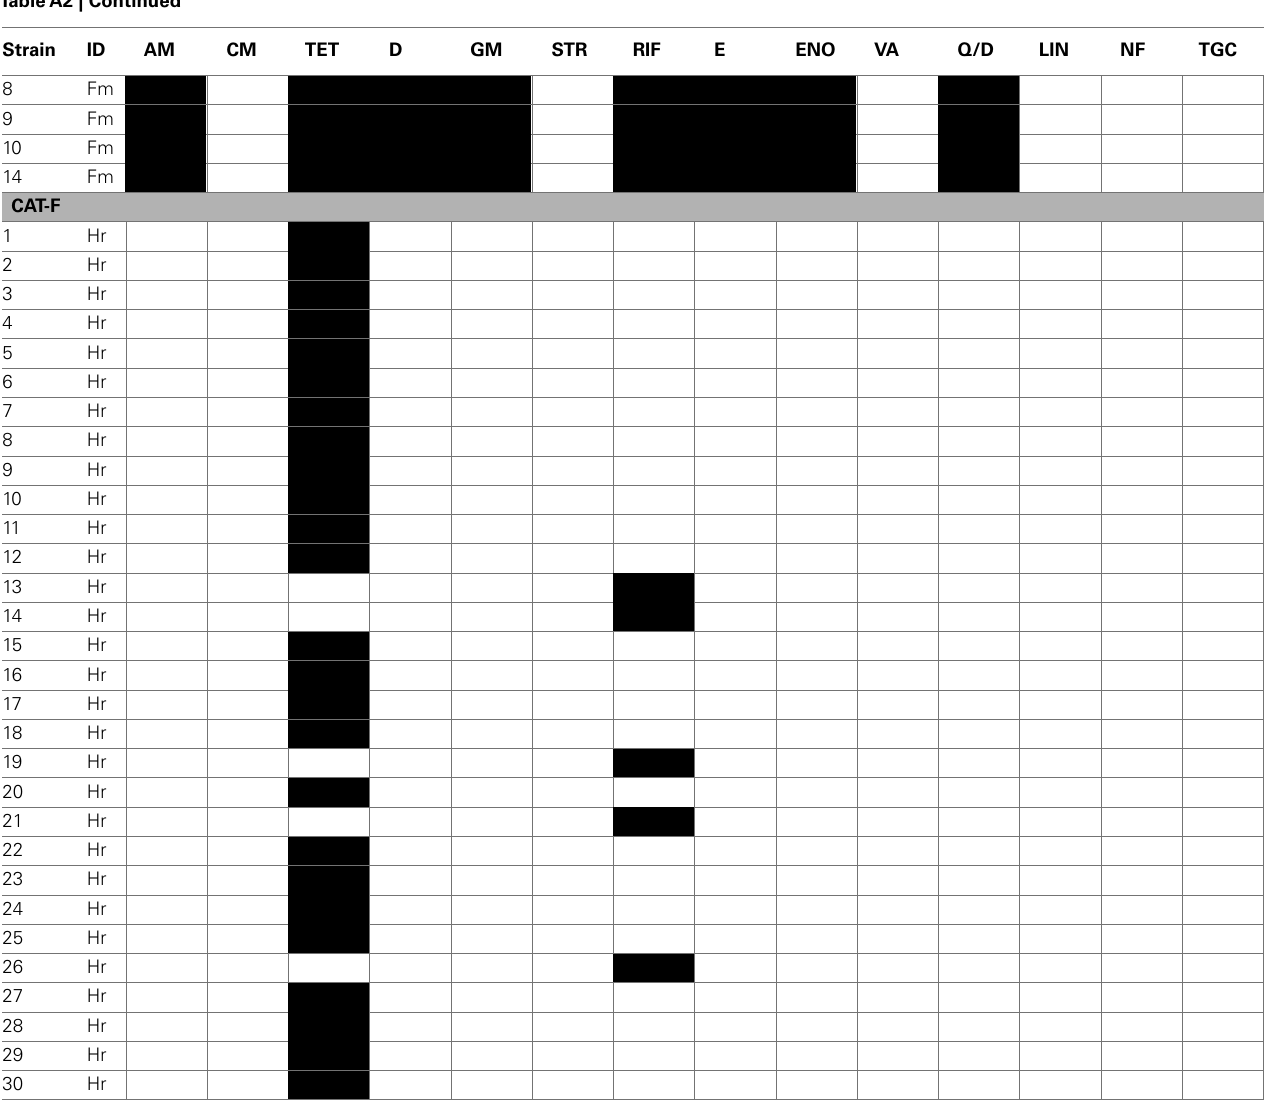
Black filled box = resistance, white filled box =